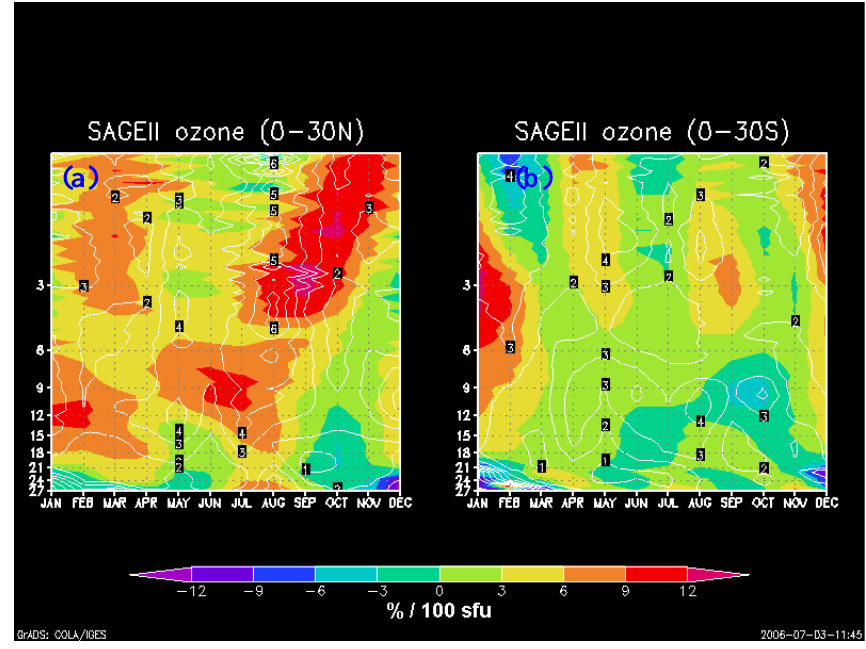
Fig. 4. Vertical distribution of monthly variation of solar coefficient (%/100 sfu) obtained from SAGE II ozone (a) 0–30 ◦ N (b) 0–30 ◦ S. Monthly variation of 1 sigma error (%/100sfu) in the solar effect on ozone is over-plotted with thin